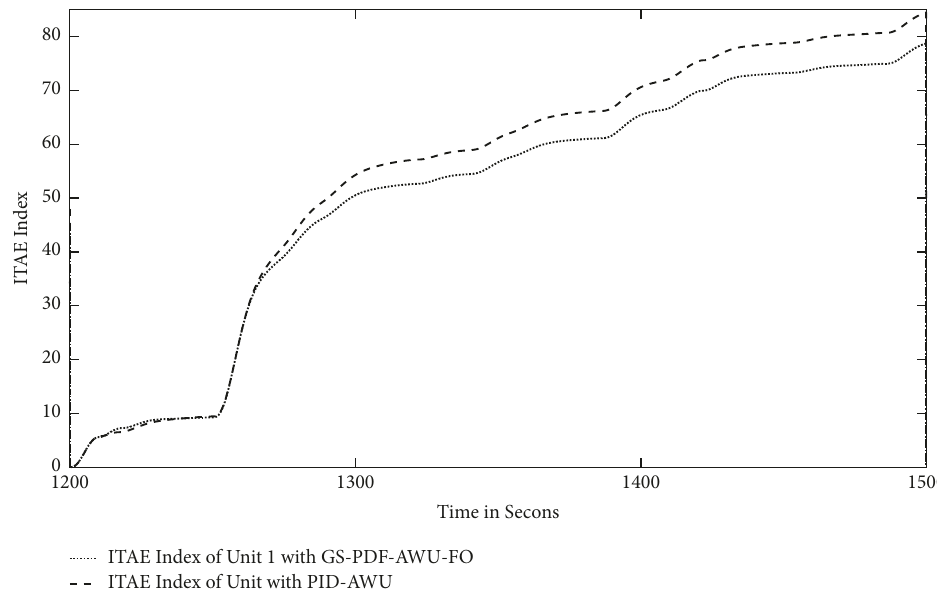
Figure 19: ITAE indexes of the comparison of the responses produced by PID and GS-PDF-FO (both with antiwindup) with unit 1 in frequency variation (connected to the grid) and units 2-6 with 0.85 p.u. of fix operational point, h=0.9 p.u.